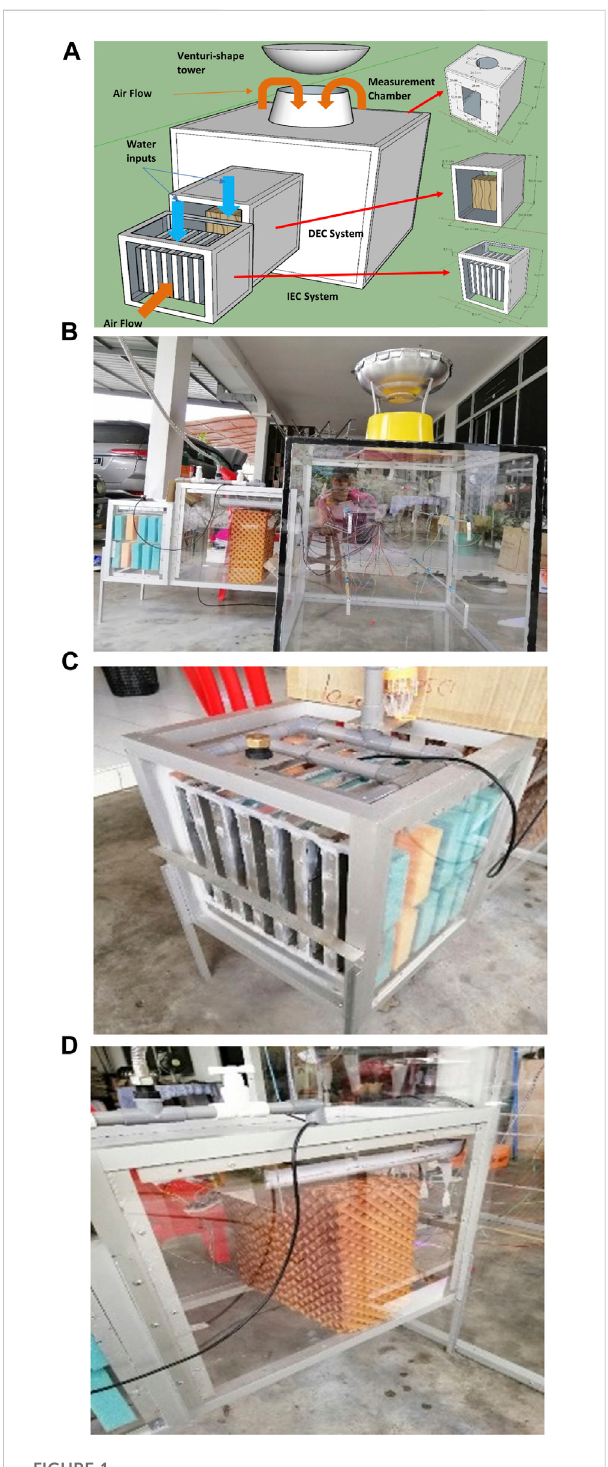
FIGURE 1 (A) Conceptual drawing of the proposed WIEC passive system with the indication of air fl ow and water input direction. (B) Corresponding assembled WIEC passive system with major components shown as (C) IEC component and (D) DEC